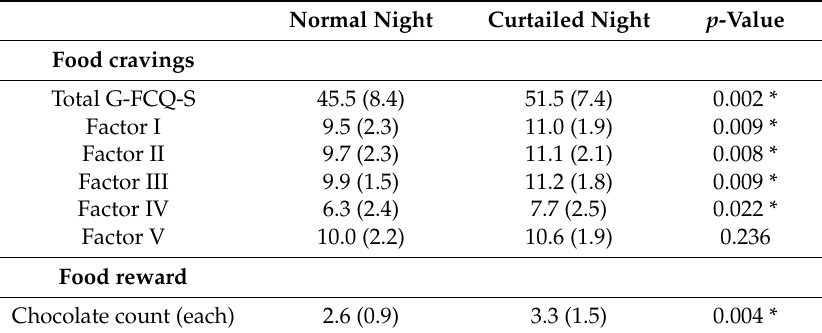
Table 4. Effects of curtailed sleep on food cravings and food reward.